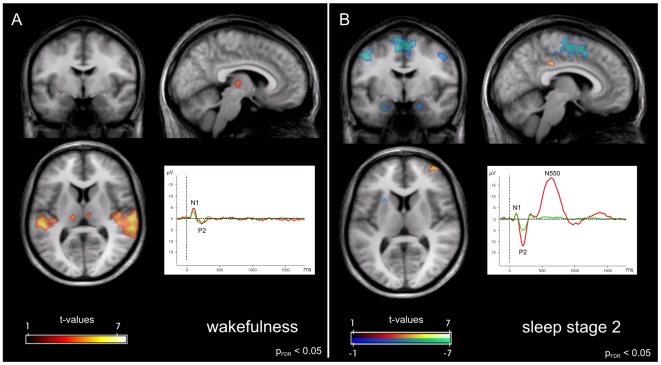
Neuronal responses to rare tones as compared to frequent tones.Comparison between wakefulness (A) and sleep stage 2 (B). Orthogonal views at MNI coordinates x = 7, y = −5, z = 7. Inserts show ERPs to frequent (green) and rare tones (red) at electrode position Cz. FMRI data are thresholded at pFDR<0.05, cluster extent>10.